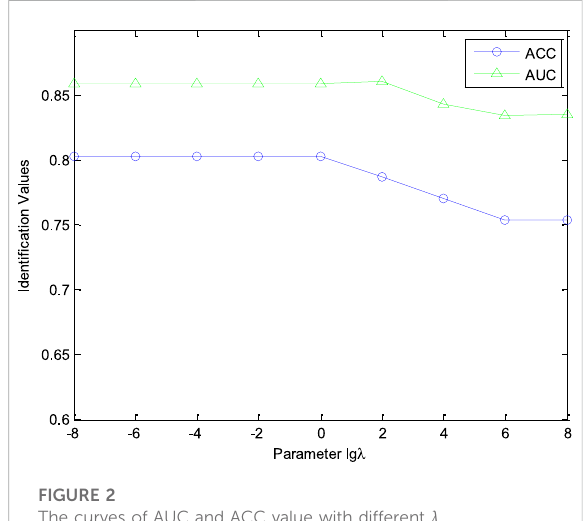
FIGURE 2 The curves of AUC and ACC value with different λ